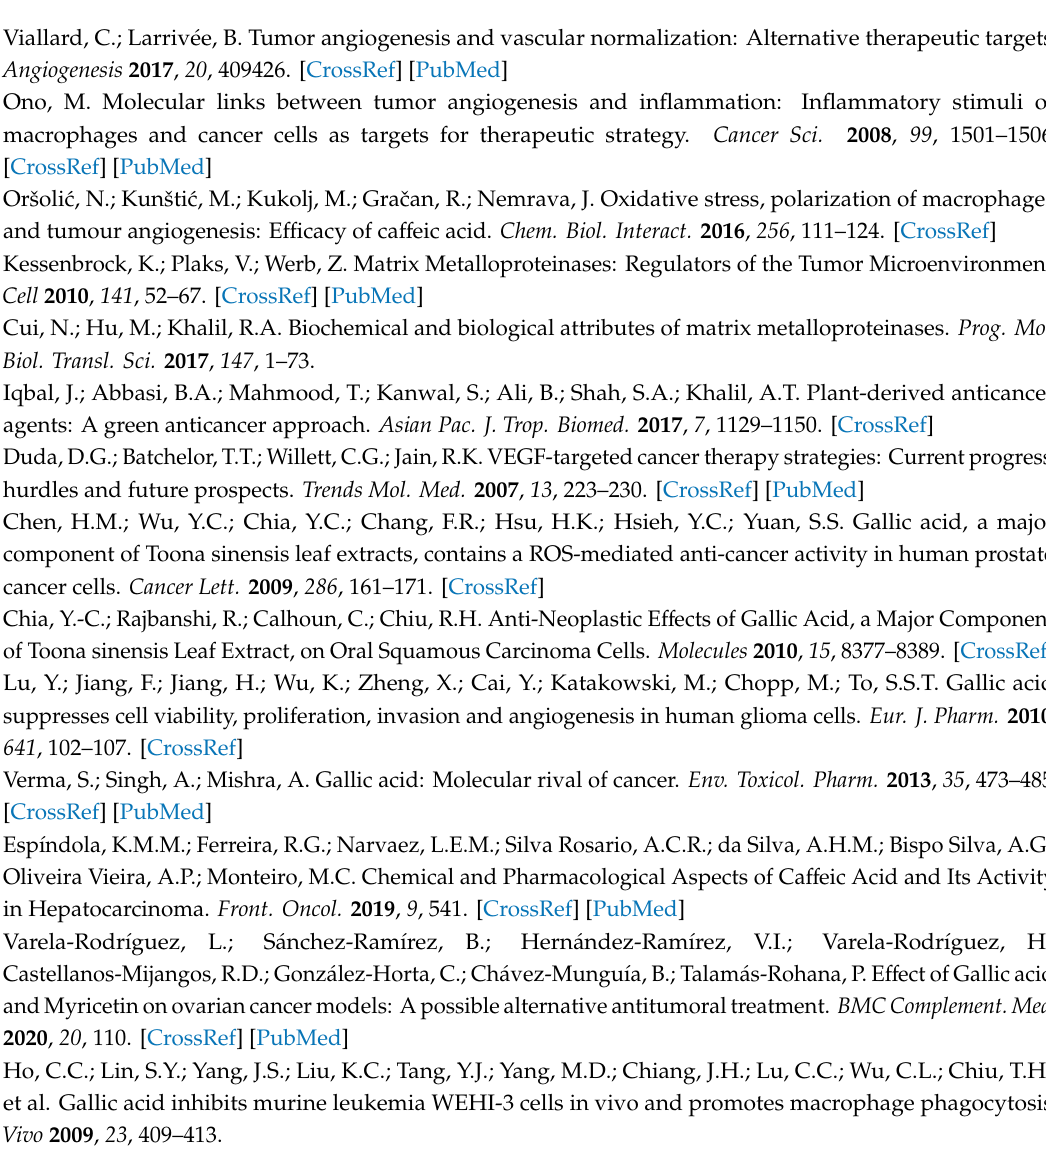
Supplementary Materials: The following are available online. Figure S1: E ff ect of GA and CA on body weight change (%) of mice bearing